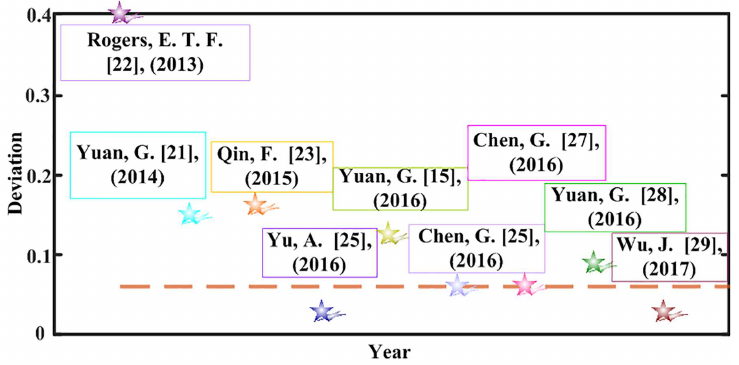
Figure 1. The deviation of the focusing properties of SOLs in recent